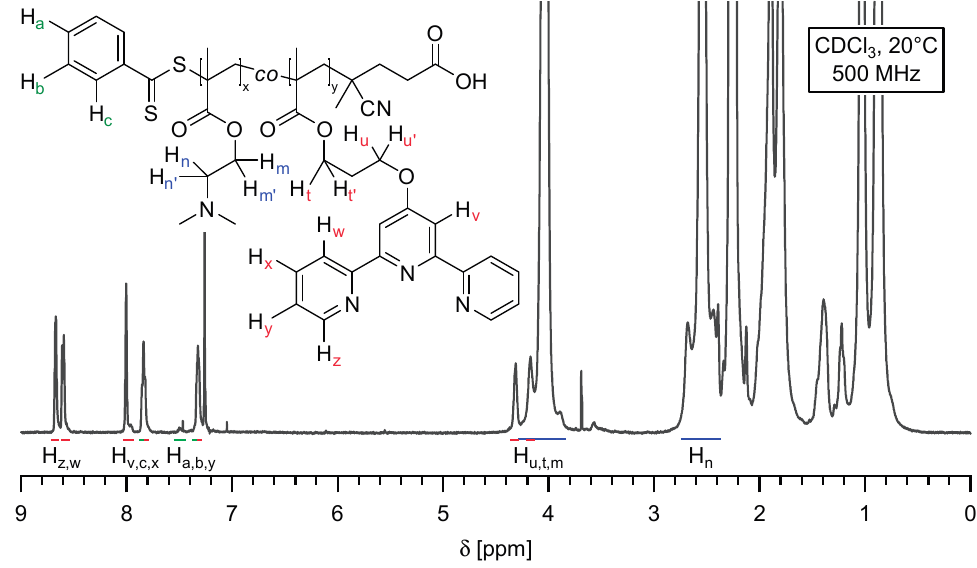
Figure 3. 1 H NMR spectrum of pure P(DMAMEA 200 - co -TpyMA 4.5 ) copolymer in deuterated chloroform as